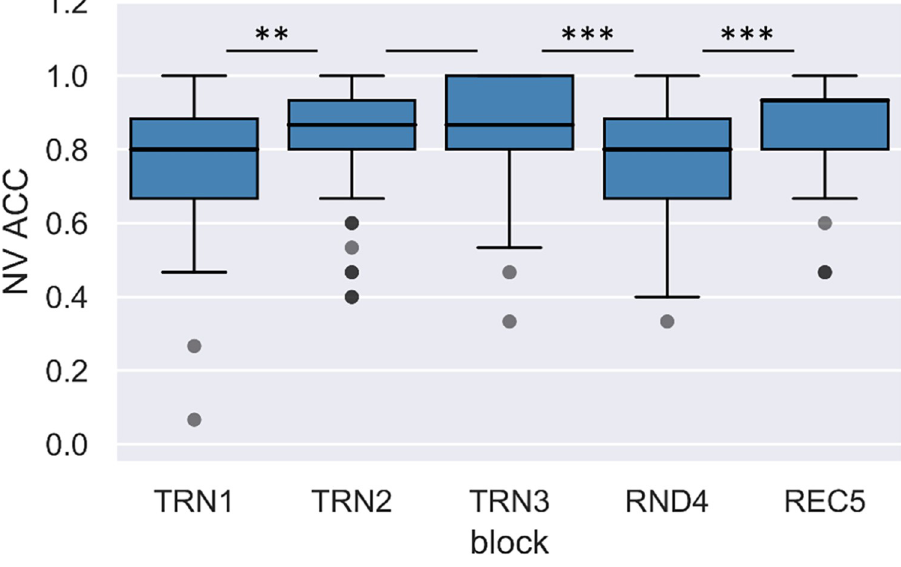
Fig 6. Accuracy rates across blocks in the nonverbal visual condition. Boxes indicate accuracy data between the first and third quartiles, horizontal lines indicate medians, and whiskers illustrate the range of data, and individual dots outside the range represent